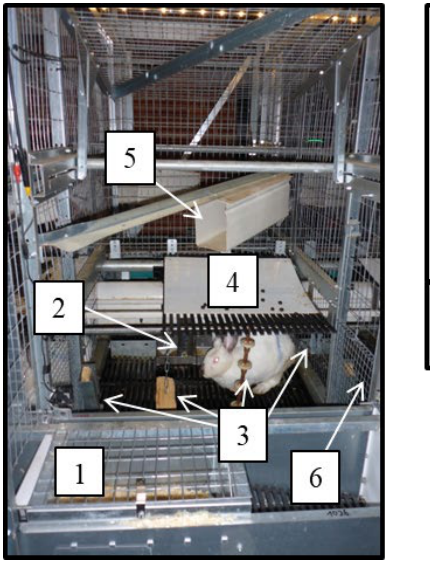
Figure 1. Photograph of one individual unit and scheme of a group pen for three does with nests (1), feeders (2), enrichment (3), platforms (4), plastic tube (5), and doors (6) for joining individual units to a group pen (adapted with permission from Bill et al. [25]. 2020, Elsevier).